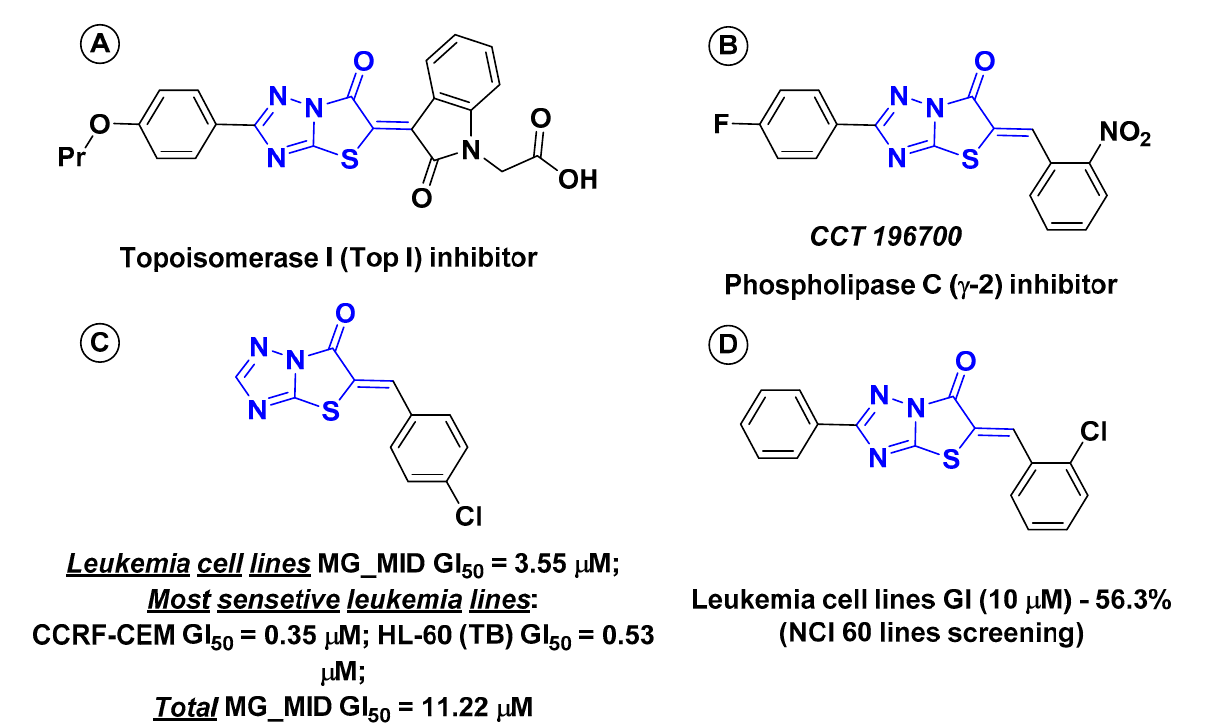
Figure 2. 5-Ene-thiazolo[3,2- b ][1,2,4]triazole-6(5 H )-ones with anticancer properties.